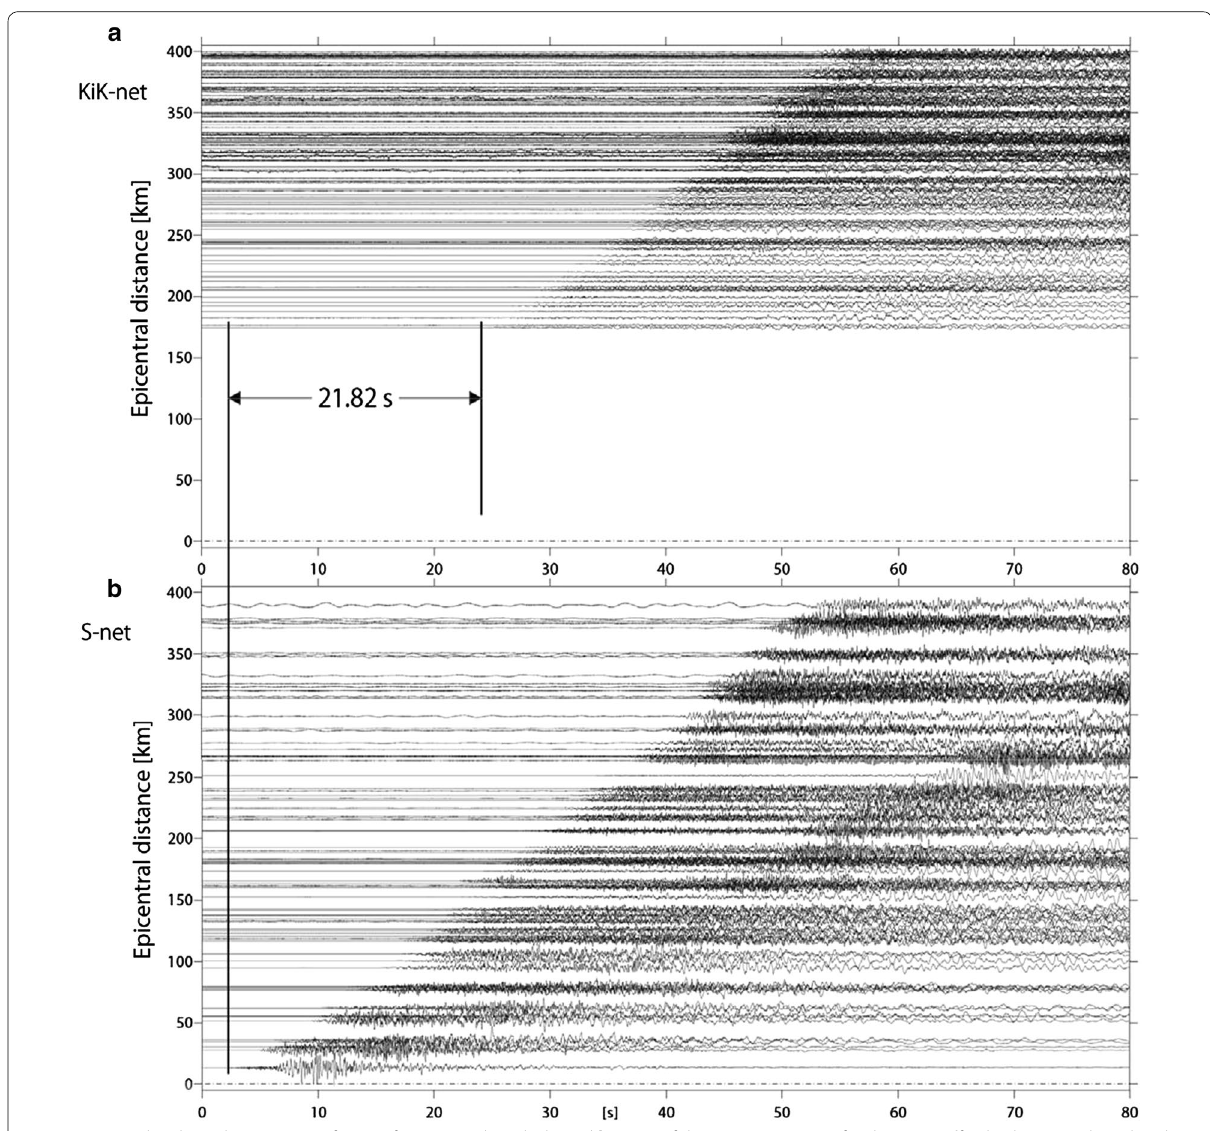
Fig. 14 Normalized acceleration waveforms of a KiK-net downhole and b S-net of the UD component for the 2016 off Fukushima earthquake. The horizontal and vertical axes indicate the time after the origin time and the epicentral distance,